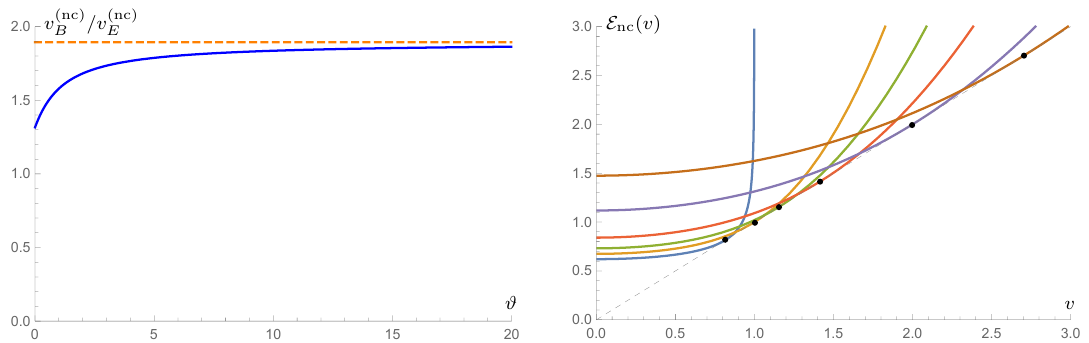
Figure 8 . Left: ratio between the butterfly velocity and the entanglement velocity as a function of the dimensionless combination ϑ = λπ 4 T 4 θ 2 . We also show the asymptotic value v B /v E → (5 / 3) 5 / 4 ≈ 1 . 894 , depicted in orange. Right: membrane tensions for ϑ ∈ { 0 , 1 / 2 , 1 , 2 , 5 , 10 } , from bottom to top, respectively. In each case, we indicate the point at which the curve touches the straight line E ( v B ) = v B